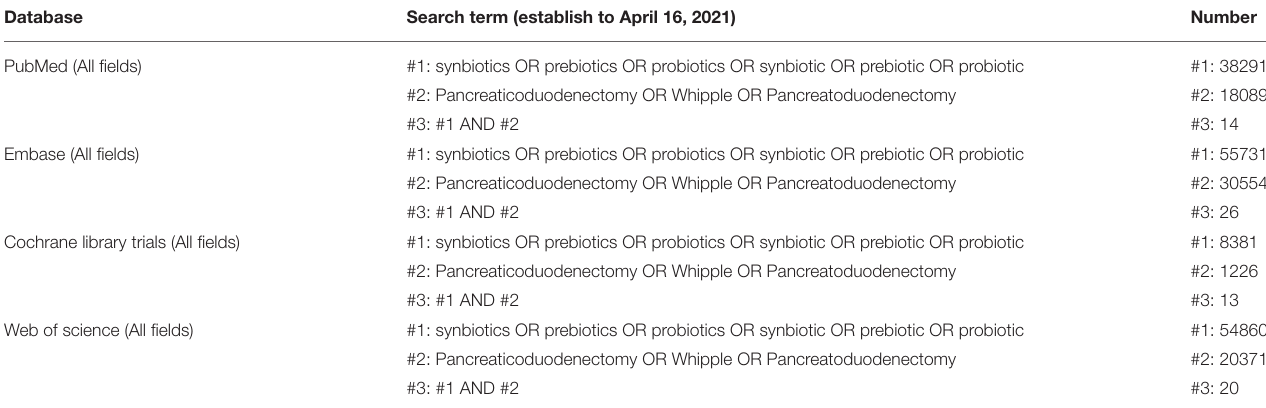
TABLE 1 | Electronic search strategy.